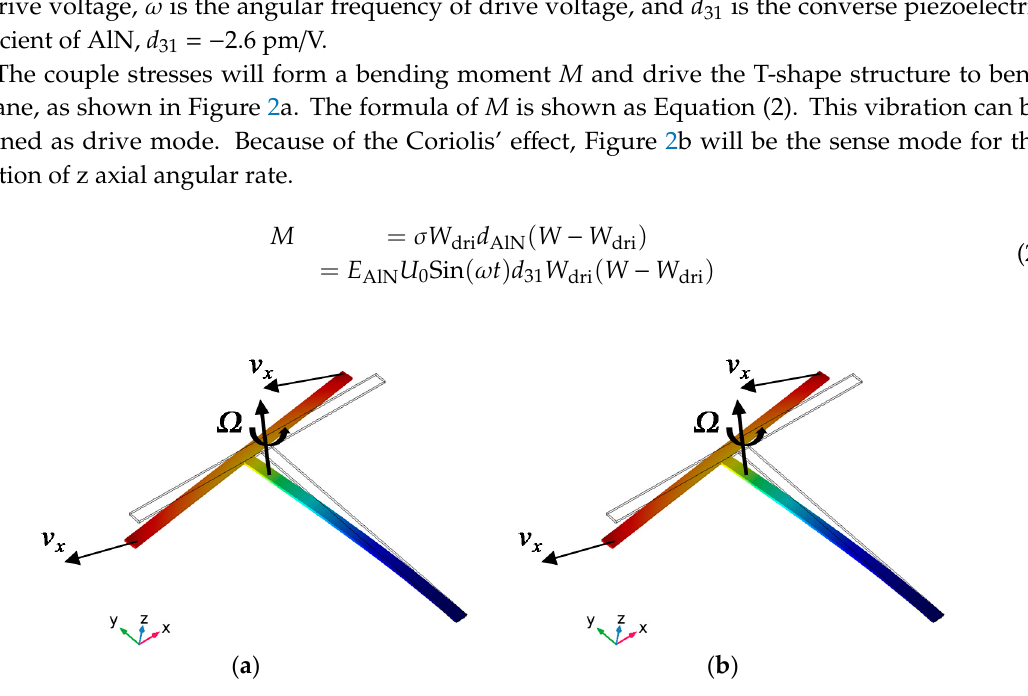
Figure 2. The bending vibration of T-shape structure. Drive mode ( a ) and sense mode ( b ).